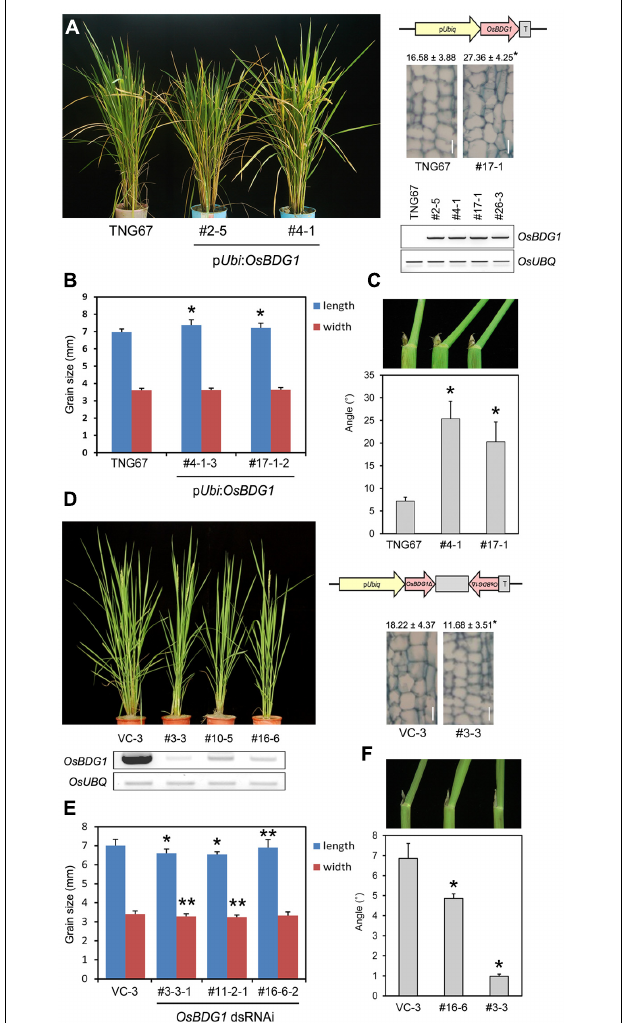
FIGURE 2 | Transgenic rice plants with p Ubi : OsBDG1 and OsBDG1 -dsRNAi constructs. (A–C) Overexpression of OsBDG1 driven by ubiquitin promoter caused increase of leaf angles with cell length in the lamina joint and grain size. Longitudinal sections of the second leaf lamina joint are shown in (A) with measured cell length. Values are means ± SD ( µ m, n > 20) as instructed by Zhang et al. (2009). ( ∗ P < 0.01, Student’s t -test). Bar = 20 µ m. Semi-quantitative RT-PCR was conducted for OsBDG1 expression in transgenic rice plants together with WT. Twenty-four PCR cycles for both OsBDG1 and OsUBQ were applied. Values of grain size and leaf angles are presented as means ± SD in (B) ( n = 35; ∗ P < 0.01, Student’s t -test) and (C) ( n > 10; ∗ P < 0.01, Student’s t -test), respectively. (D–F) Reduced expression of OsBDG1 by dsRNAi- OsBDG1 approaches resulted in erect leaves with shorter cells in lamina joint and smaller grains. The 384 bp-fragment of OsBDG1 amplified by primers 5 (cid:48) ATGGGGGCTCATTCTGCAGCGGCAGCTC 3 (cid:48) and 5 (cid:48) GTGCCACTCAGTGAATTCTTCTGAAGCTC 3 (cid:48) was used for the dsRNAi construct. Semi-quantitative RT-PCR was conducted for OsBDG1 expression in transgenic rice plants together with vector control (VC). Thirty-five and 24 PCR cycles were used for OsBDG1 and OsUBQ , respectively. Longitudinal sections of the second leaf lamina joint are shown in (D) with measured cell length ( µ m, n > 20; ∗ P < 0.01, Student’s t -test). Bar = 20 µ m. Values of grain size and leaf angles are presented in (E) ( n > 25; ∗ P < 0.01; ∗∗ P < 0.05, Student’s t -test) and (F) ( n > 8; ∗ P < 0.01,